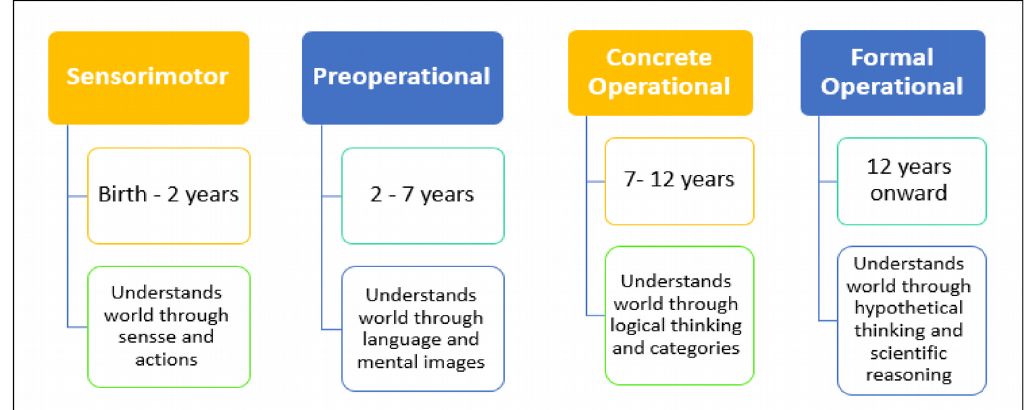
Figure 1. Piaget’s Theory of Cognitive